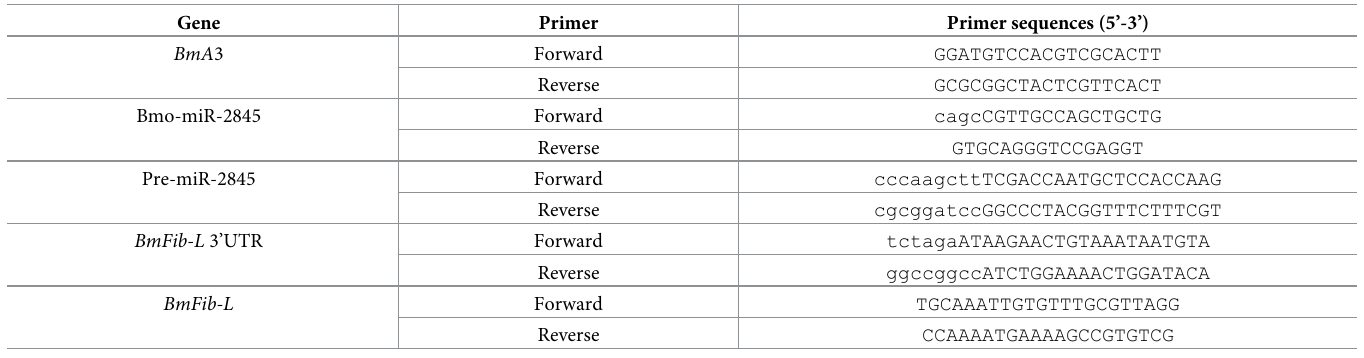
Table 1. Primer sequences.